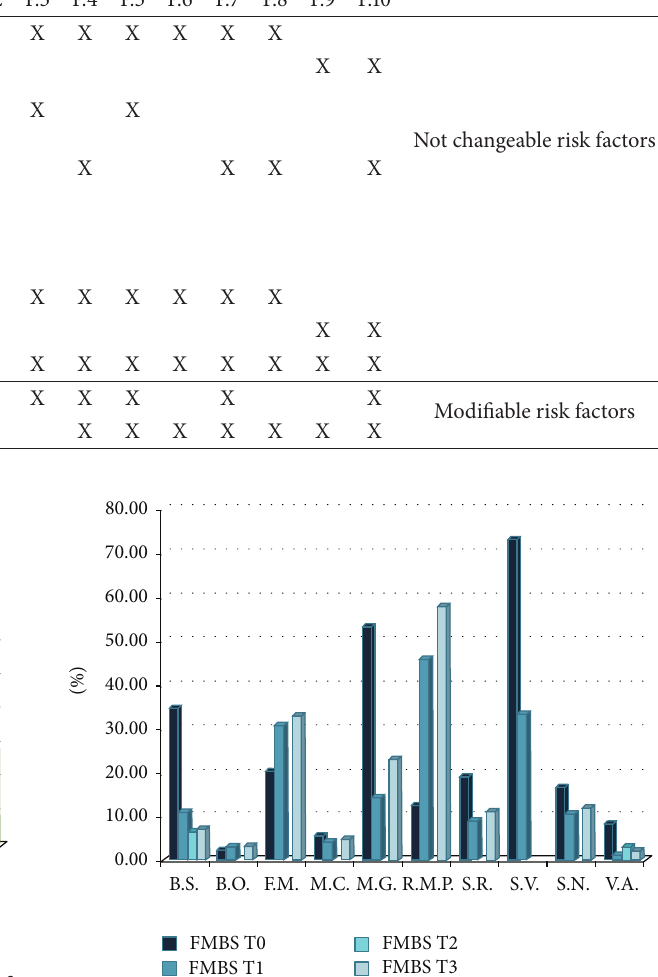
Figure 1: FMPS detected before the start of therapy (T0) and 3 months (T1), 6 months (T2), and 18 months (T3) after. The patient S.V. died before the follow-up at 18 months.